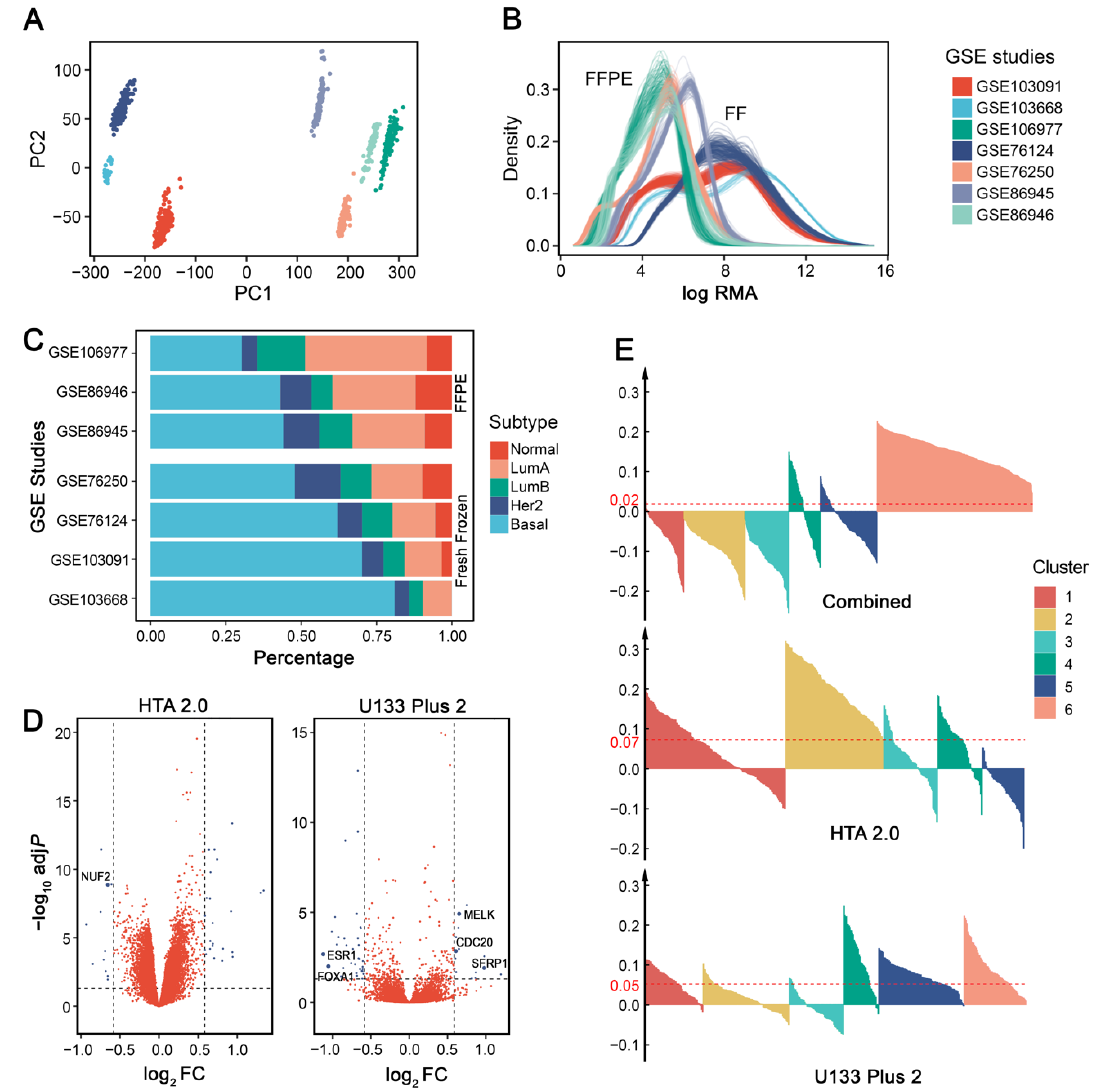
Figure 2. Effects of sample preservation and batch effect removal on TNBC subtyping. ( A ) PCA plot of the 7 datasets (GSE103668, GSE103091, GSE76124, and GSE76250 were generated from FF tissues; GSE86945, GSE86946, and GSE106977 were generated from FFPE samples) without batch effect removal. ( B ) Log-transformed robust multichip average (RMA) value density distribution of each dataset. ( C ) Intrinsic subtyping of 7 datasets using PAM50 centroids. ( D ) Volcano plot of differentially expressed genes between datasets using FFPE and FF tissues. ( E ) Average silhouette width of different batch effect removal schemes. From top to bottom: Combining datasets from HTA 2.0 and U133 Plus 2 by cross-platform batch effect removal; Removing batch effect separately for datasets from HTA 2.0 and U133 Plus 2, respectively. The red lines represent the value of the average silhouette width across all samples.